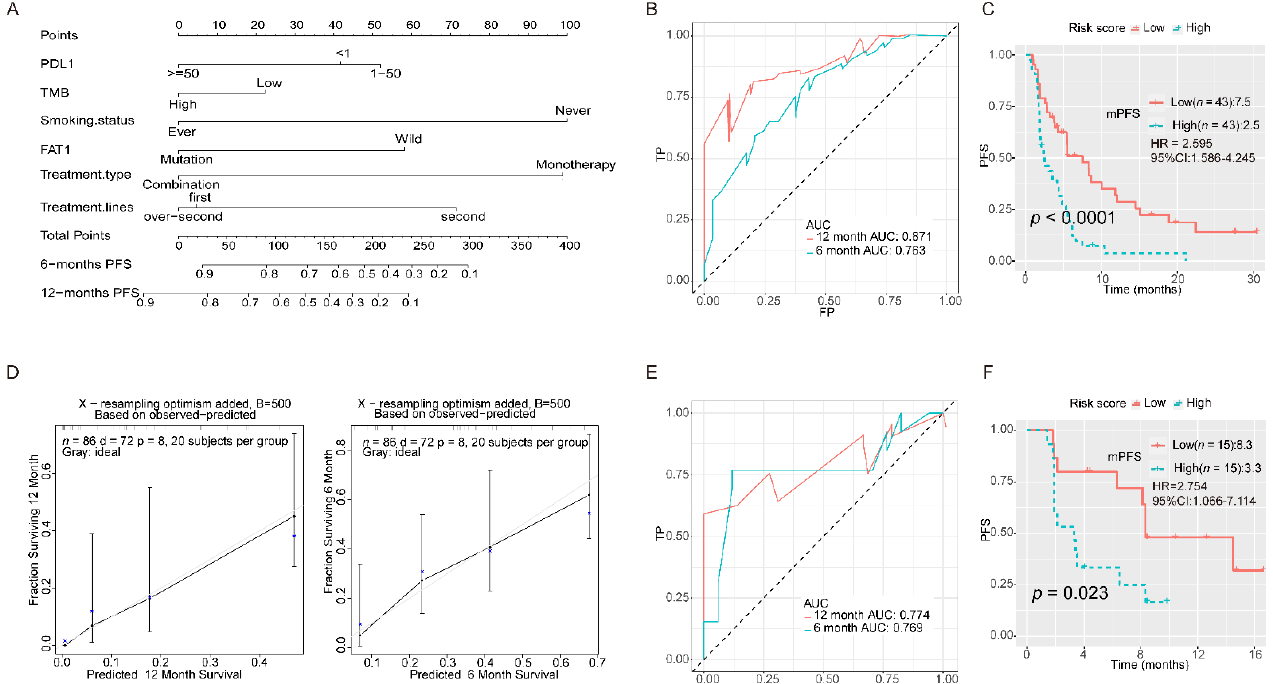
Figure 6. Construction of an integrated prognostic classifier model. ( A ) A nomogram based on PD-L1 expression, tumor mutation burden (TMB), smoking status, treatment regimen, treatment type, and FAT1 mutation status in the Rizvi cohort. ( B ) Receiver operating characteristic (ROC) curves for predicting progression-free survival (PFS) using the nomogram for the Rizvi cohort. ( C ) The PFS curve with the nomogram for the Rizvi cohort. The risk score is calculated according to the regression coefficient. According to the risk score, the cohort is divided into low-risk and high-risk score groups for Kaplan Meier survival analysis. ( D ) Calibration plot of the nomogram to determine the probability of PFS at 6 months (right) and 12 months (left) in the Rizvi cohort. ( E ) ROC curves for predicting PFS of the nomogram in the Naiyer cohort. ( F ) The survival curve for PFS with the nomogram according to the risk score in the Naiyer cohort.